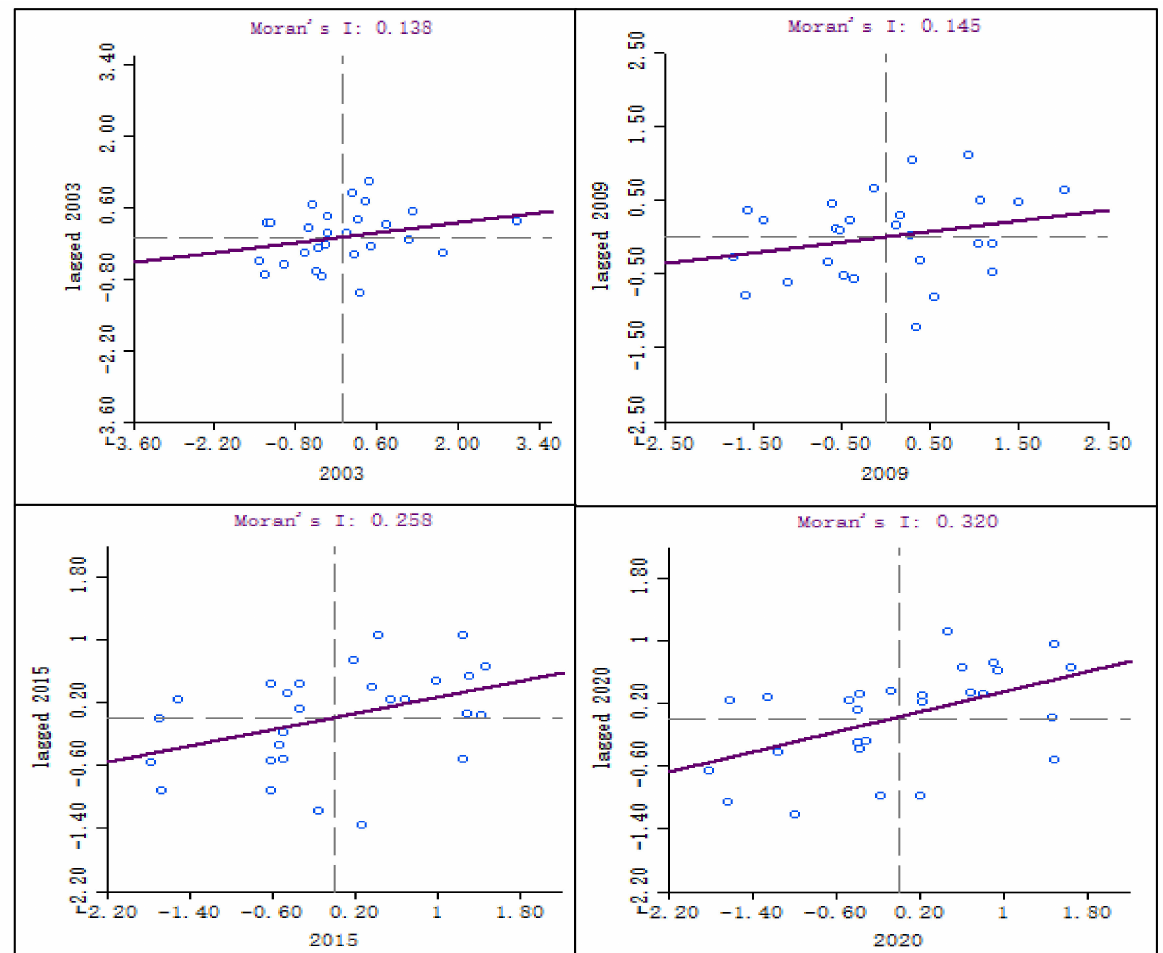
Figure 5. Moran scatterplot of urban-rural integration levels in the Yangtze River Delta 2003, 2009, 2015,